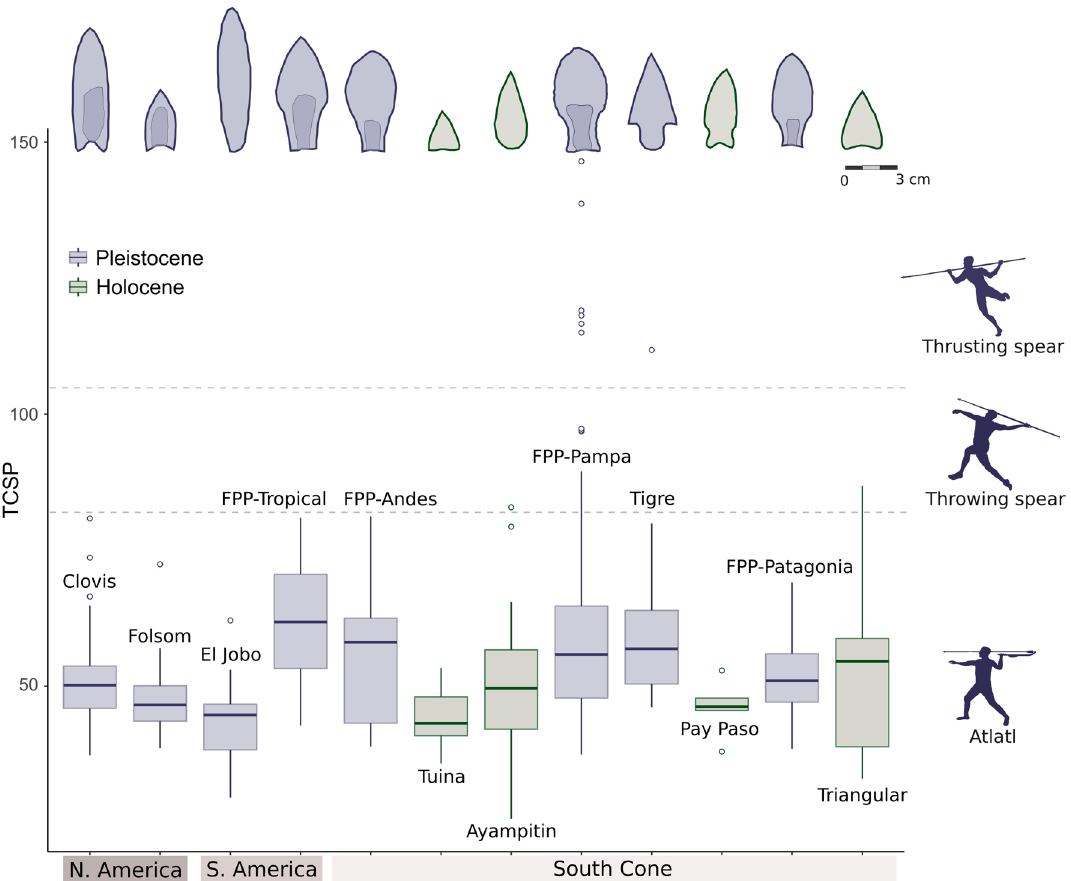
Figure 5. Box-plots of TCSP index by projectile point type (values expressedin millimeters), displaying the typical form of each type at the top of the x-axis. The graph shows the minimum and maximum